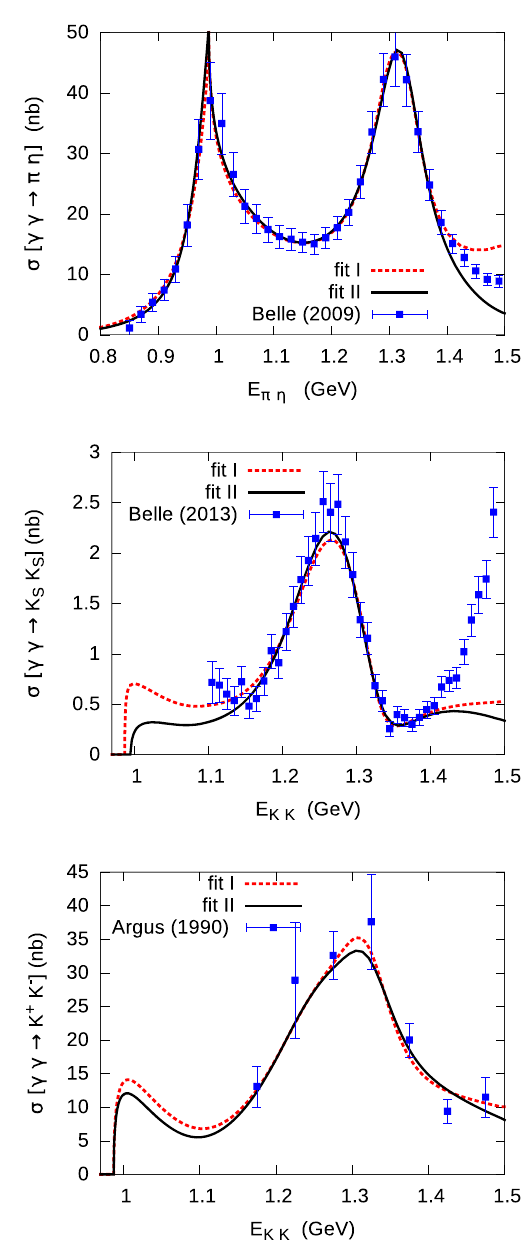
Fig. 7 Cross-sections for γγ → πη, K S K S , K + K − integrated in the range | cos θ | < 0 . 8. The data are from Refs. [13,16,44], they are com- pared with the two fits